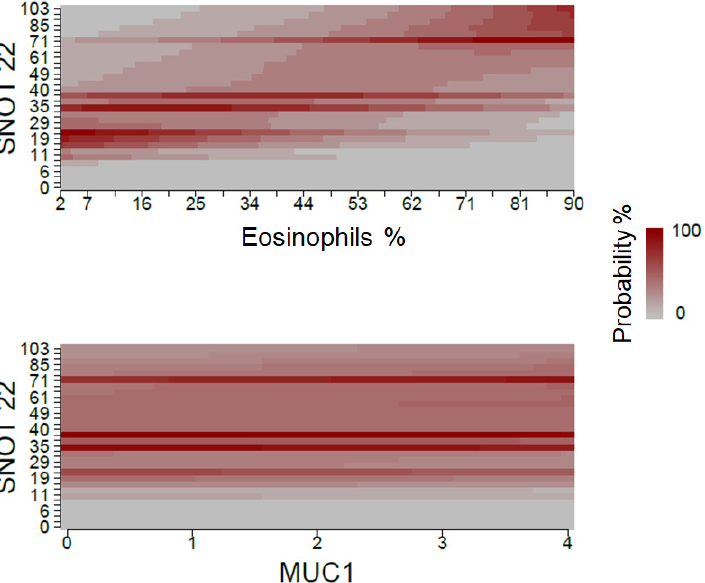
Figure 2. Association between eosinophil percentage and MUC1 expression, and QoL measured with SNOT-22. The expression of target genes was expressed as 2 elevated—deltaCt.